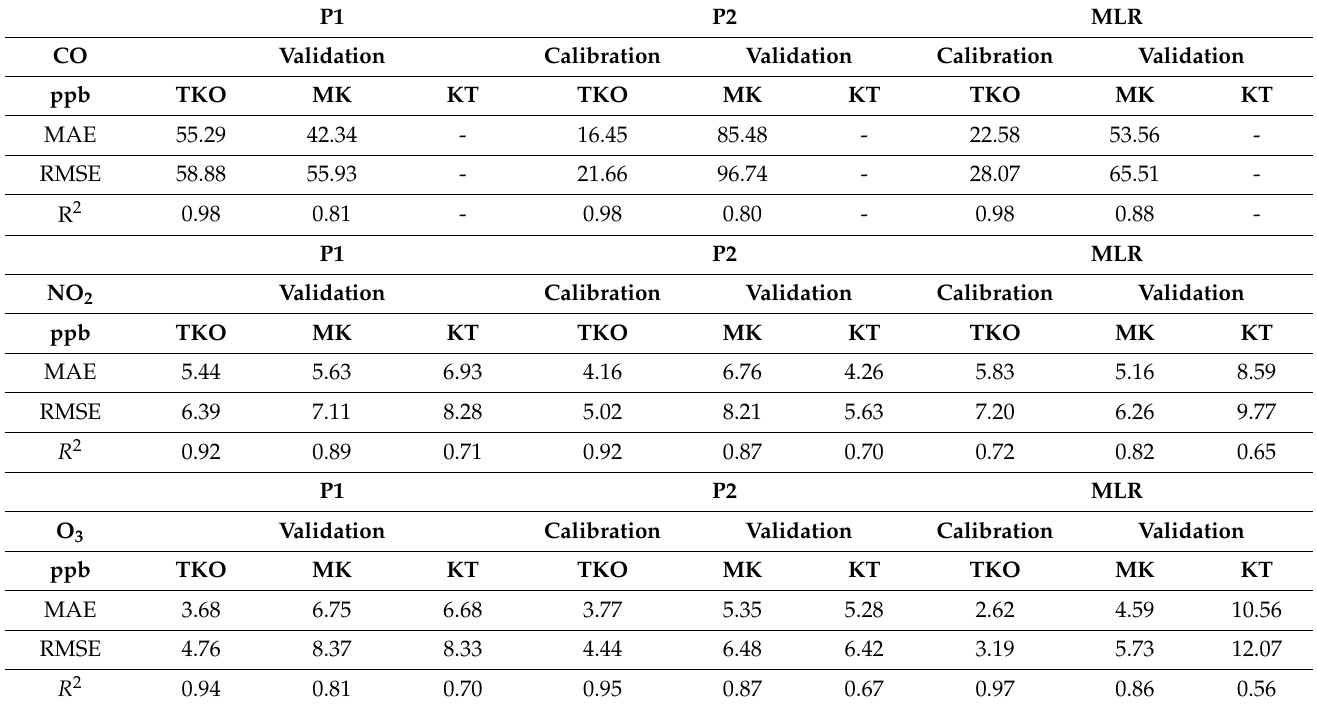
Table 1. Statistical analysis of measurements from the Personal Exposure Kit (PEK) calibrated using Protocol 1 (P1), Protocol 2 (P2) and multi-linear regression (MLR) as mean absolute error (MAE), root mean square error (RMSE) and the coefficient of determination (R 2 ) during the entire on-site test period at government monitoring stations Tseung Kwan O (TKO), Mong Kok (MK) and Kwun Tong